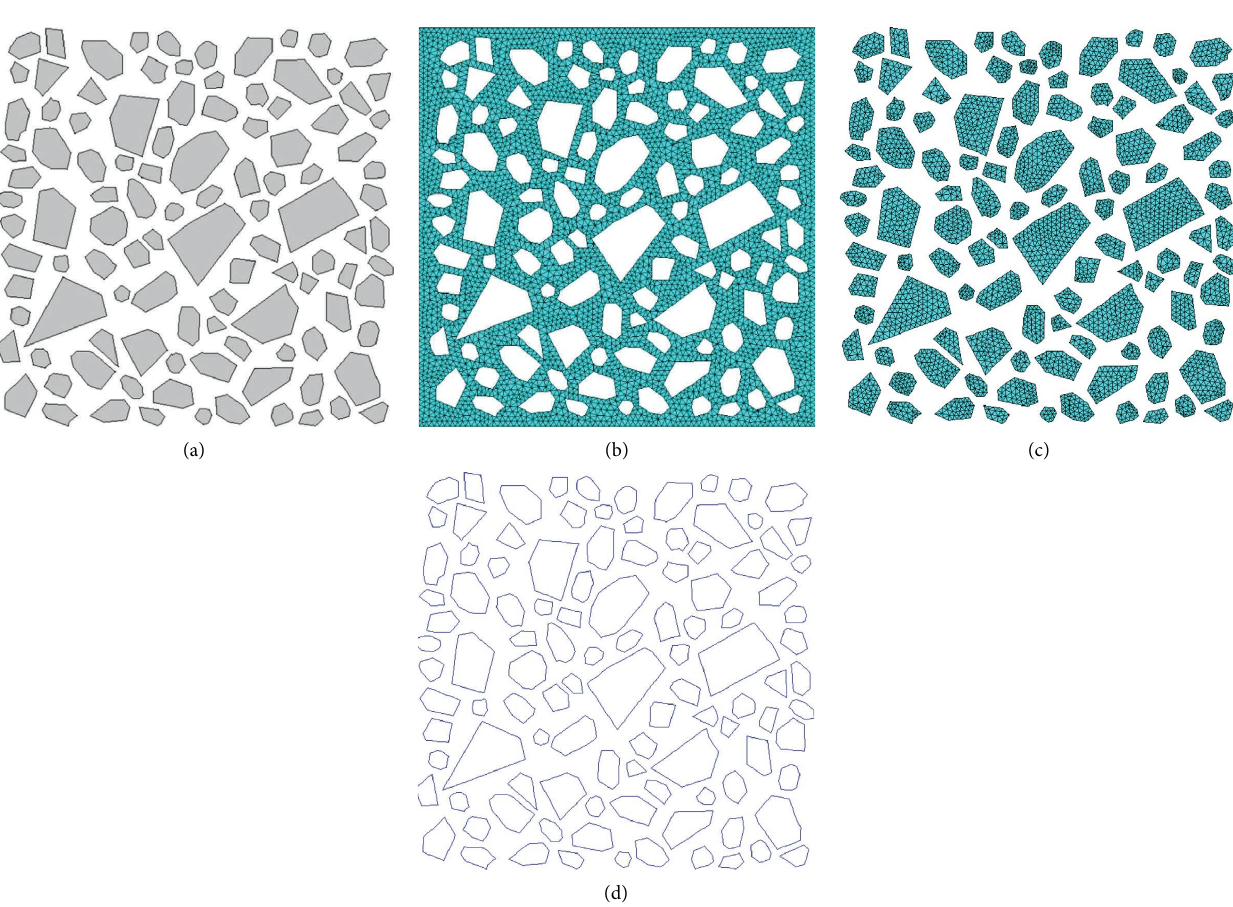
Figure 1: Random aggregate model and its mesh. (a) Random aggregate model. (b) Mortar mesh profle. (c) Aggregate mesh profle. (d) Transition zone mesh profle.